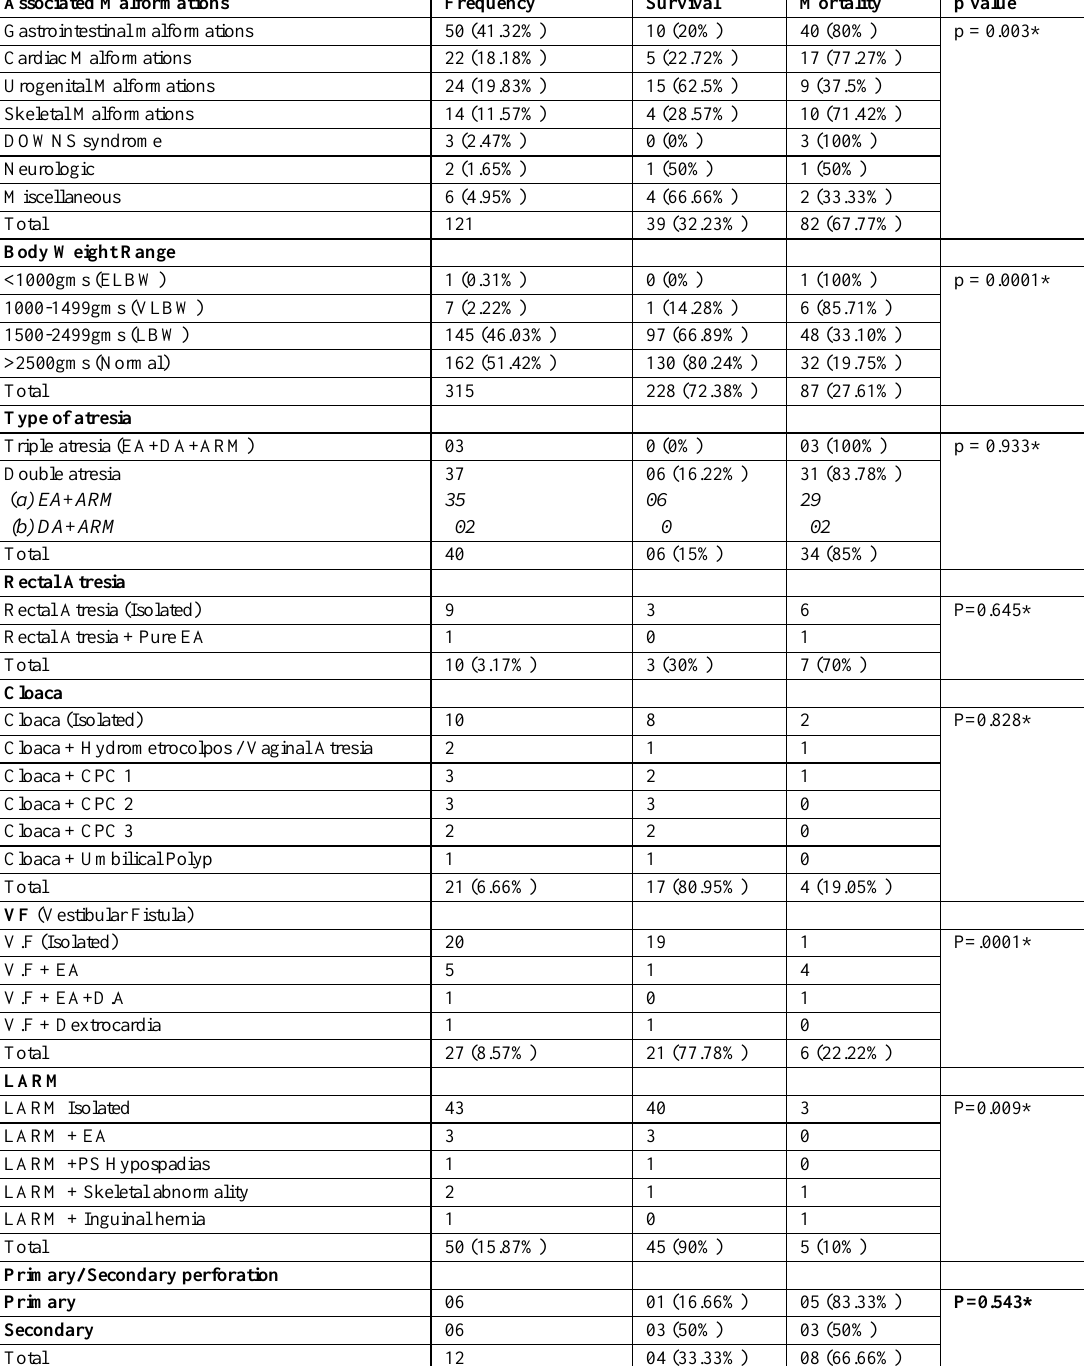
Table 2: Predictors of neonatal surgical mortality in ARM patients [*Chi-square